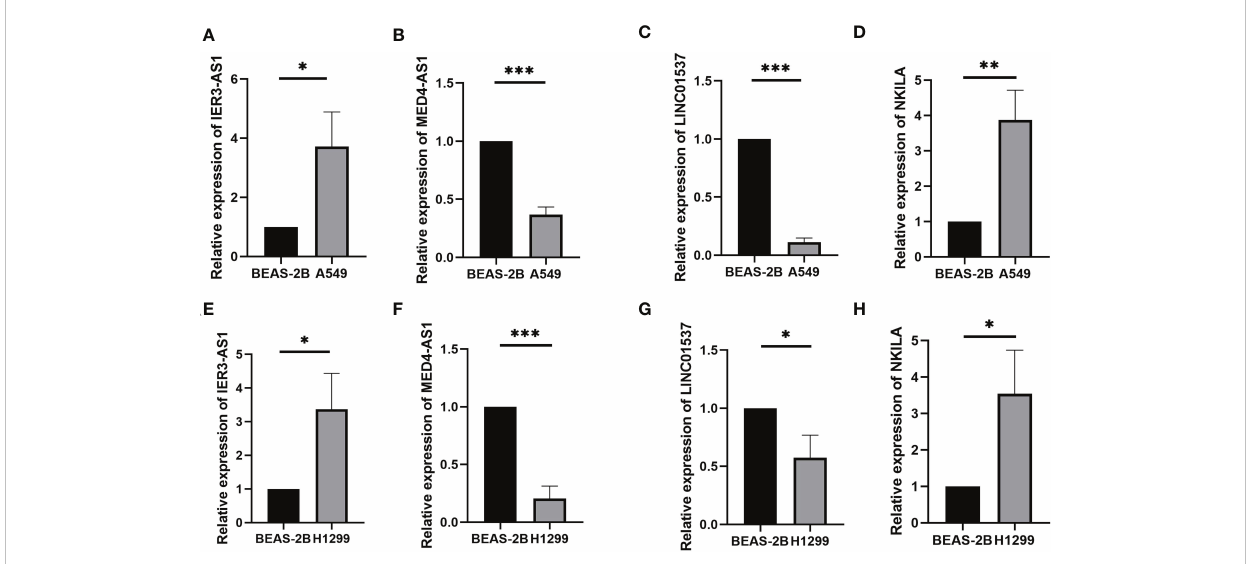
FIGURE 3 The expression of LINC01537, IER3-AS1, NKILA and MED4-AS1 in the A549 cell lines (A – D) and H1299 cell lines (E – H) . *p < 0.05; **p < 0.01; ***p < 0.001.